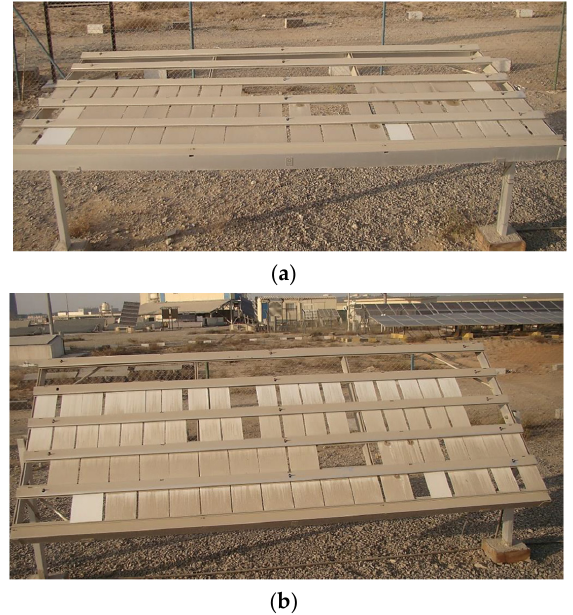
Figure 6. High SRI coating samples mounted on racks after 6 months of exposure. ( a ) Roof applica ‐ tion—5° tilt; ( b ) Facade application—45° tilt. application—5 ◦ tilt; ( b ) Facade application—45 ◦ tilt.